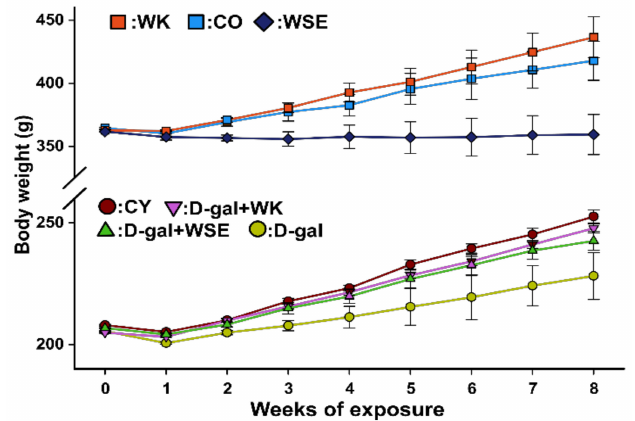
Figure 1. Body weight variation in D-gal-induced aging and naturally aged rats ( n = 8) during the experiment (CO—control old; WK—walnut kernel; WSE—walnut septum extract; CY—control young;